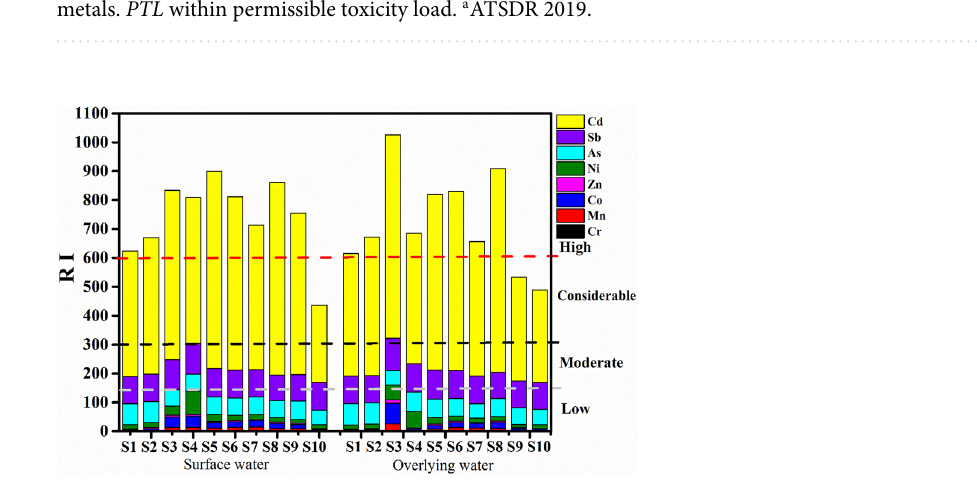
Table 4. Heavy metal toxicity load (HMTL, μg/L) of the surface water based on the relative level of heavy metals. PTL within permissible toxicity load. a ATSDR 2019.